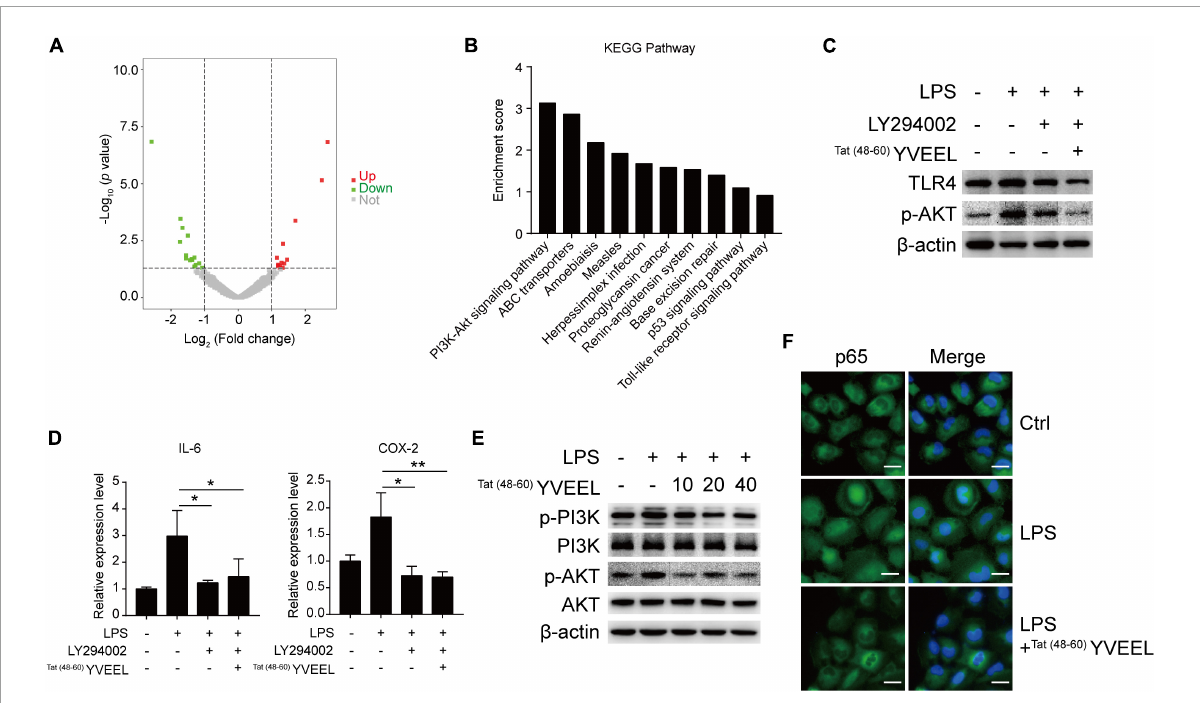
FIGURE3 Phosphatidylinositol 3-kinase (PI3K)/AKT pathway was involved in the protective effects of Tat ( 48 - 60 ) YVEEL in FHC cells. Cells were pretreated with Tat ( 48 - 60 ) YVEEL at 40 µ M for 1 h, followed by LPS treatment. (A) Volcano plot of genes differentially expressed in LPS and LPS + Tat ( 48 - 60 ) YVEEL treated FHC cells, up- and downregulated genes with fold change ≥ 2.0 are highlighted in red and green, respectively; (B) genes with differential expression between LPS and LPS + Tat ( 48 - 60 ) YVEEL treated FHC cells were subjected to KEGG pathway analysis. The top 10 most significantly KEGG pathways are shown in the graph; (C) the PI3K/AKT inhibitor LY294002 has similar effect as Tat ( 48 - 60 ) YVEEL on LPS-induced TLR4 expression in FHC cells; (D) LY294002 has similar effect as Tat ( 48 - 60 ) YVEEL on LPS-induced IL-6 and Cox-2 mRNA expression in FHC cells. * p < 0.05, ** p < 0.01; (E) Western blot analysis showing the phosphorylation of PI3K and AKT in FHC cells treated with LPS and Tat ( 48 - 60 ) YVEEL at the indicated concentration; (F) representative graphs of Control (Ctrl), LPS and LPS + Tat ( 48 - 60 ) YVEEL treated FHC cells stained